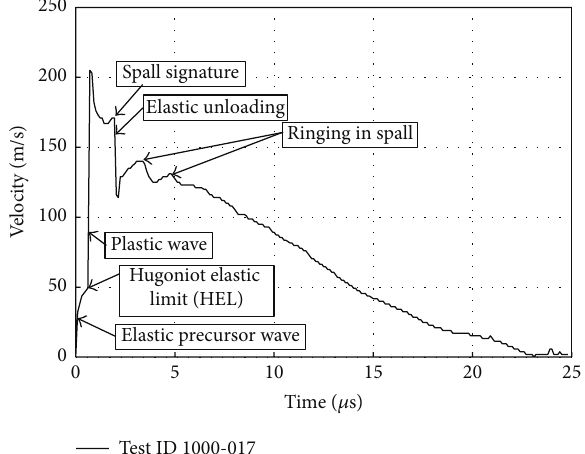
Figure 6: Typical free surface velocity data as obtained by a PDV system.